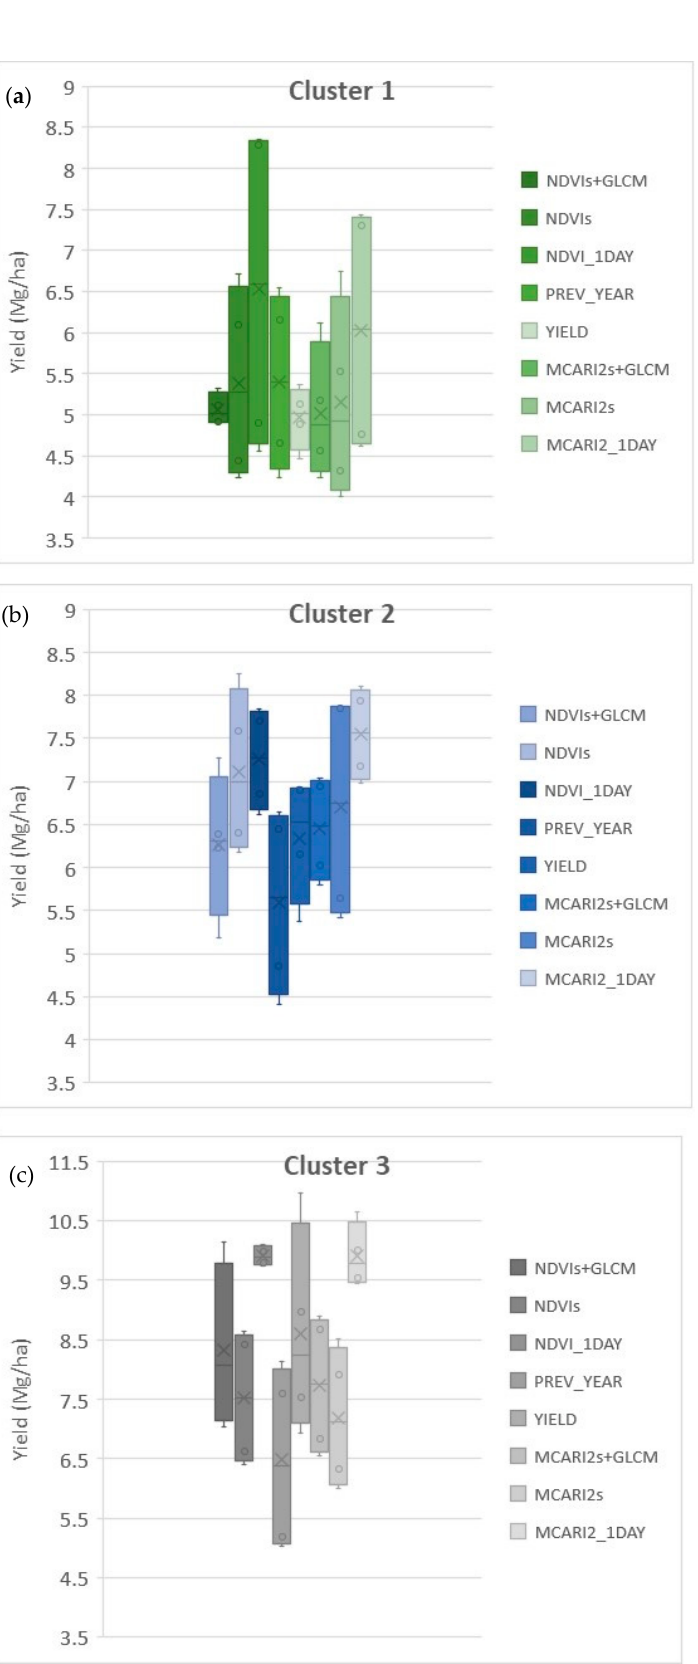
Figure 7. Boxplot of the ranges of yield values intercepted in the three clusters ( a – c ) by the meth- ods